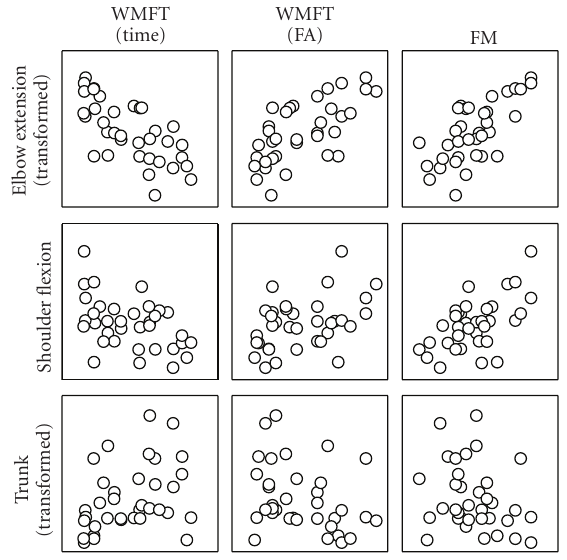
Figure 3: A scatterplot matrix of the kinematic predictor variables with the outcome